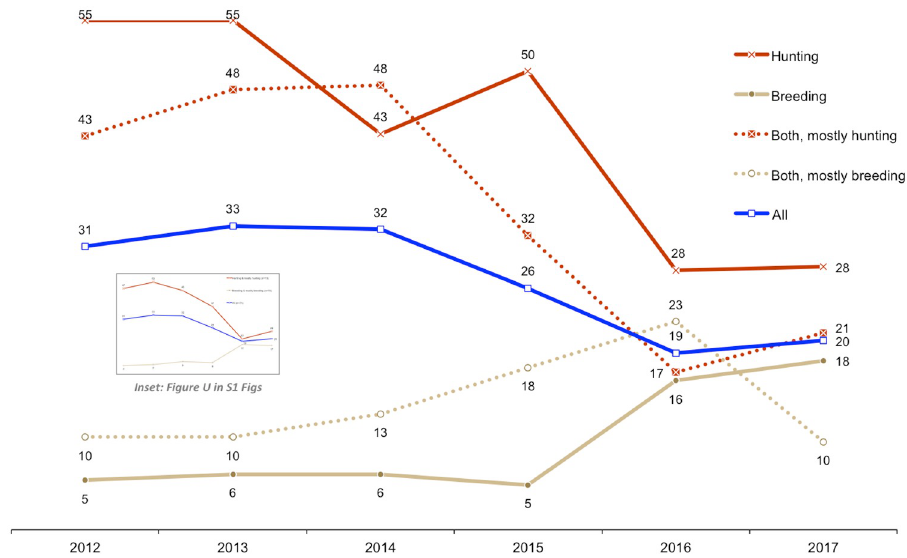
Fig 10. Comparative annual mean number of skeletons sold by responding facilities according to the primary purpose of the facilities (hunting and/or breeding). Dual-purpose facilities (‘Both’ hunting and breeding) were delimited based on answers to Question 11 and other survey questions. (Annual sample sizes and standard deviations are in Table N in S1 Tables). The inset Figure U in S1 Figs simplifies these results to three series. Results correspond to Question